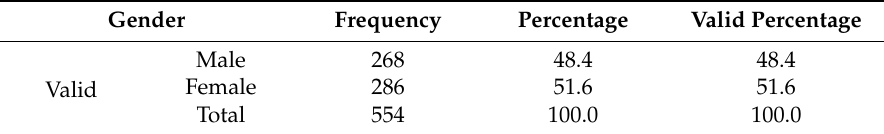
Table 1. Frequencies for the demographic variables according to